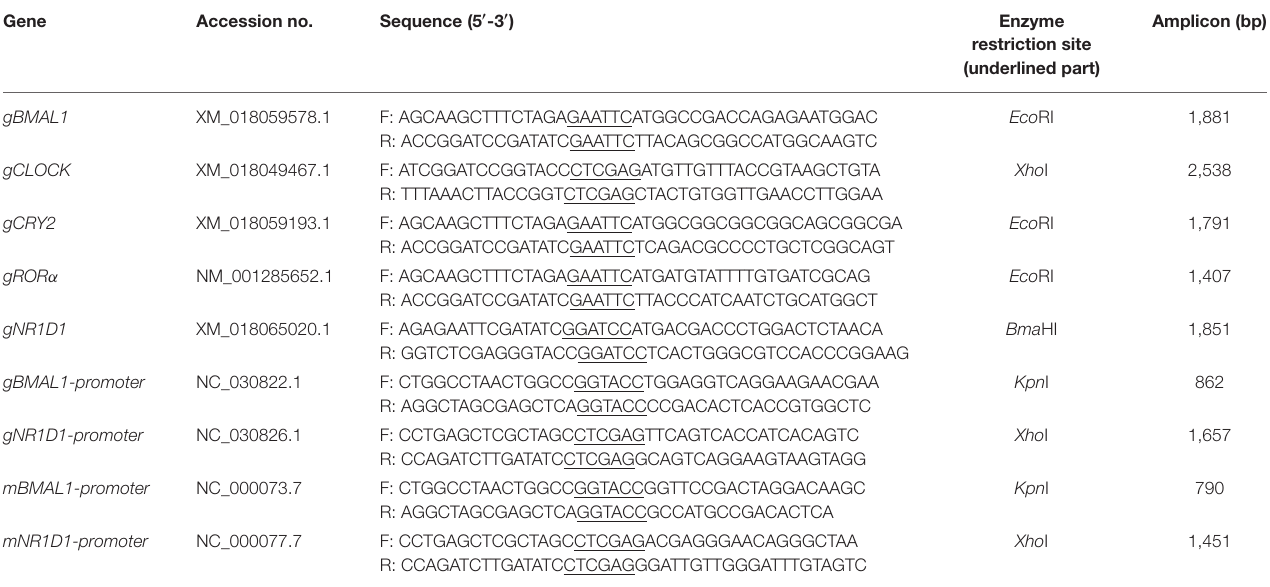
TABLE 2 | PCR primer sequences for clock genes and circadian gene